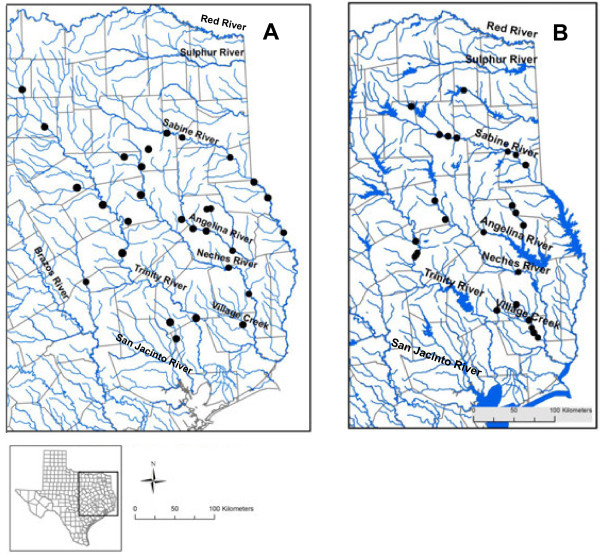
Historical (before 1940, A) and current (1990-present, B) distribution ofFusconaia askewiin East Texas. Historical data are from Pilsbry [38], Singley [37], Frierson [24], Frierson [36], Frierson [25], Strecker [34], and Bachtel [35]. Current data include authors’ data and literature records [15,26-33].